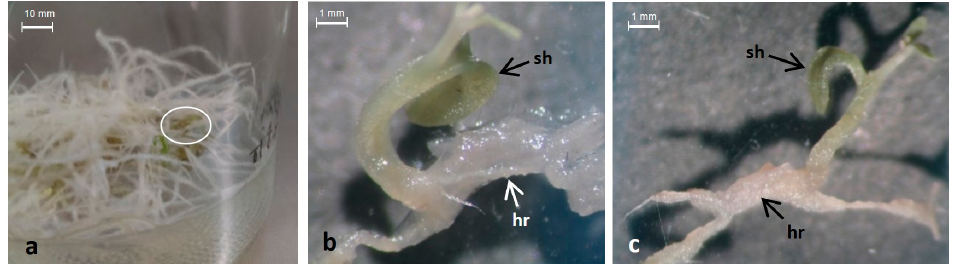
Figure 3. Stereoscopic images of shoots directly regenerated from hairy roots of the line LRT 6.4 of L. racemosa. ( a ) Oval shows regenerating hairy roots (hr) cultured on MS/B5 medium with 3.0% su- crose; ( b , c ) directly regenerated shoots (sh) showing the connection with its parent tissue (hr) 4× scale bar 10 mm ( a ) and 1 mm ( b , c ) .